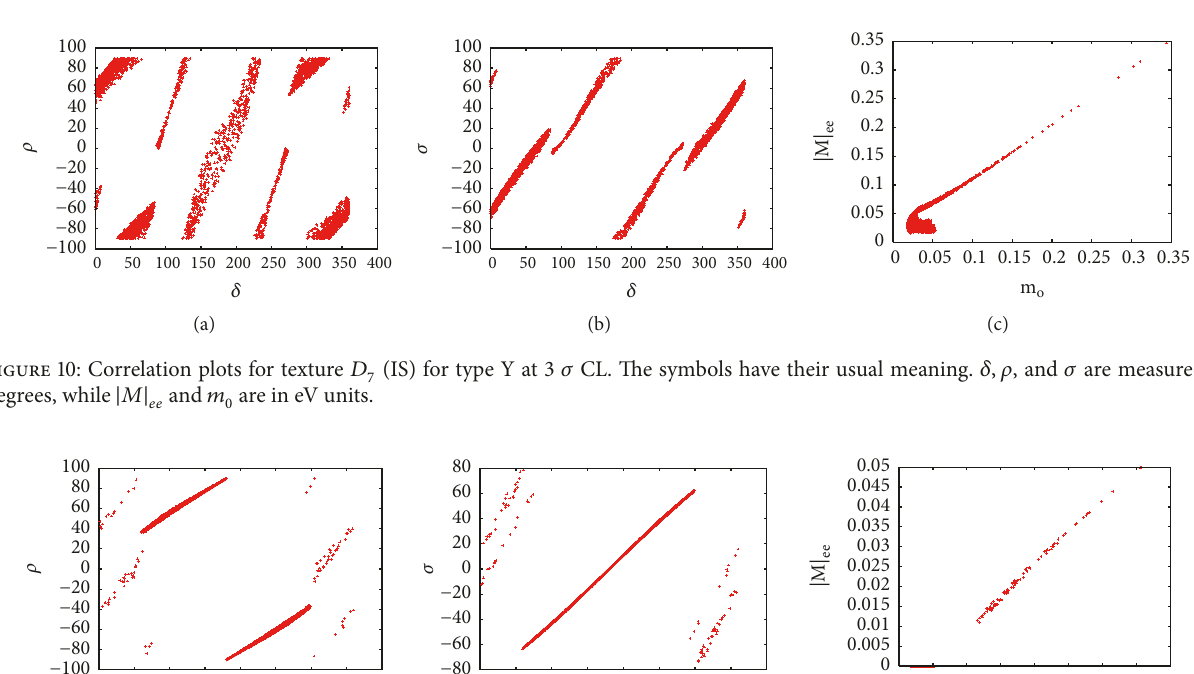
Figure 9: Correlation plots for texture 𝐷 7 (NS) for type Y at 3 𝜎 CL. The symbols have their usual meaning. 𝛿,𝜌 , and 𝜎 are measured in degrees, while |𝑀| 𝑒𝑒 and 𝑚 0 are in eV units.